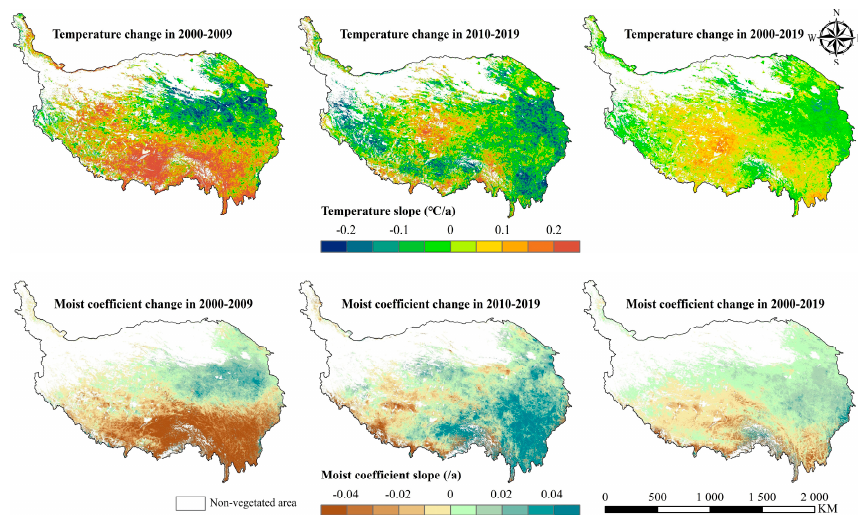
Figure 6. The spatial distribution climate change in the growing season on the QTP.